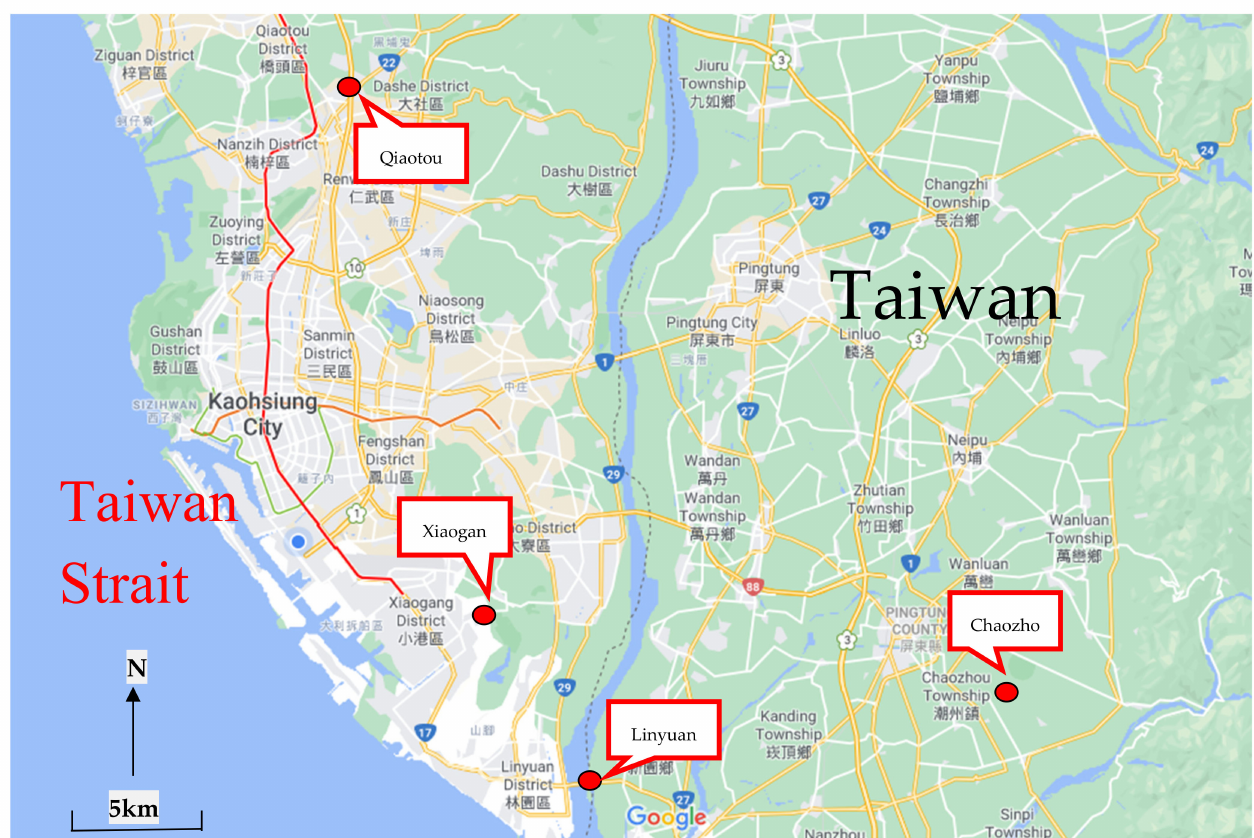
Figure 1. Photochemical monitoring stations in Kaohsiung–Pingtung area, Taiwan. Source of image: google (http://maps. www.google.com accessed on 30 August